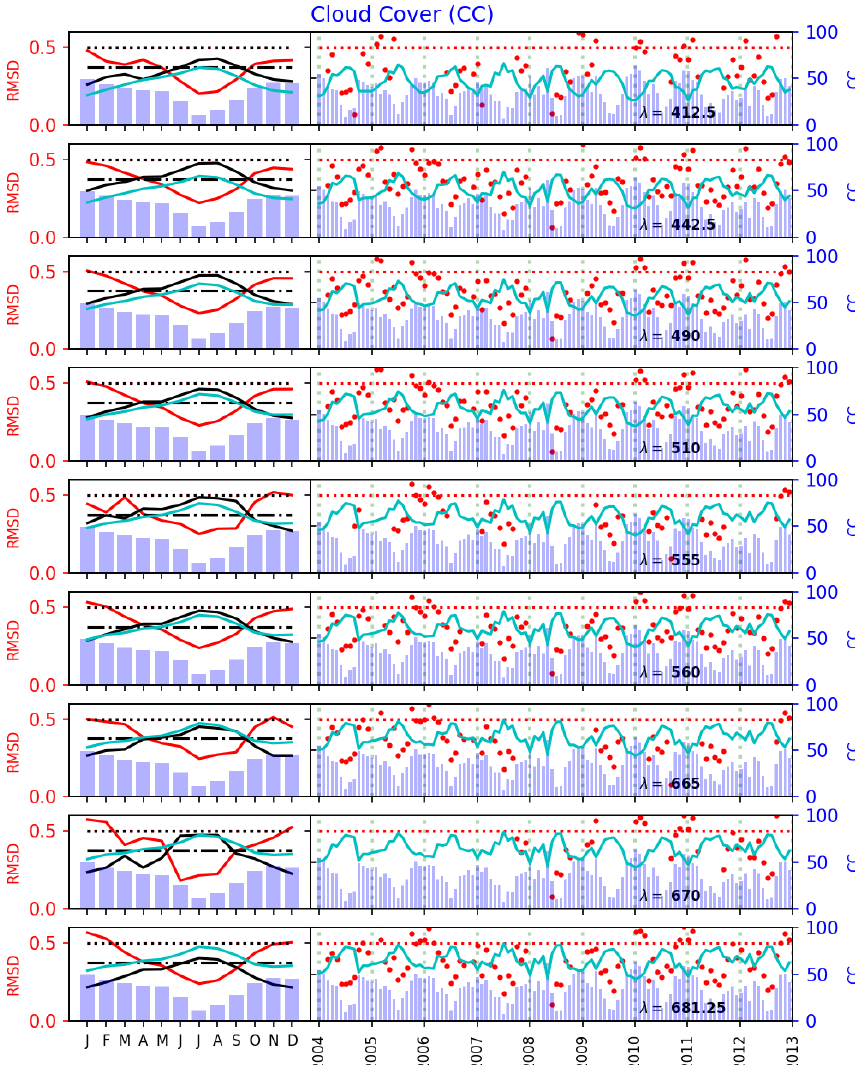
Figure 14. Comparison of the OASIM downward irradiance ( E d (λ 0 − ) at the nine wavelengths) to the BOUSSOLE data from 2004 to 2012 in terms of the RMSD and regression slope and their relationship with the ECMWF ERA-Interim cloud cover (CC). The left section of each panel shows the monthly climatology of the RMSD (normalized by its averaged value; red lines and labels) and regression slope (normalized by its averaged value; black line), superimposed on the monthly climatology of the cloud cover (in %, blue bars and labels). Regression slope thresholds at 1 (dotted black line) and 0.75 (dot–dashed black line) are also shown. The right section of each panel shows the monthly means of the time series of the RMSD (red dots, with a 0.5 value; red dotted line), superimposed on the monthly means of the time series of the cloud cover (blue bars and labels). The IND parameter defined in Eq. (3) is also reported (cyan lines) and in all panels varies in the range